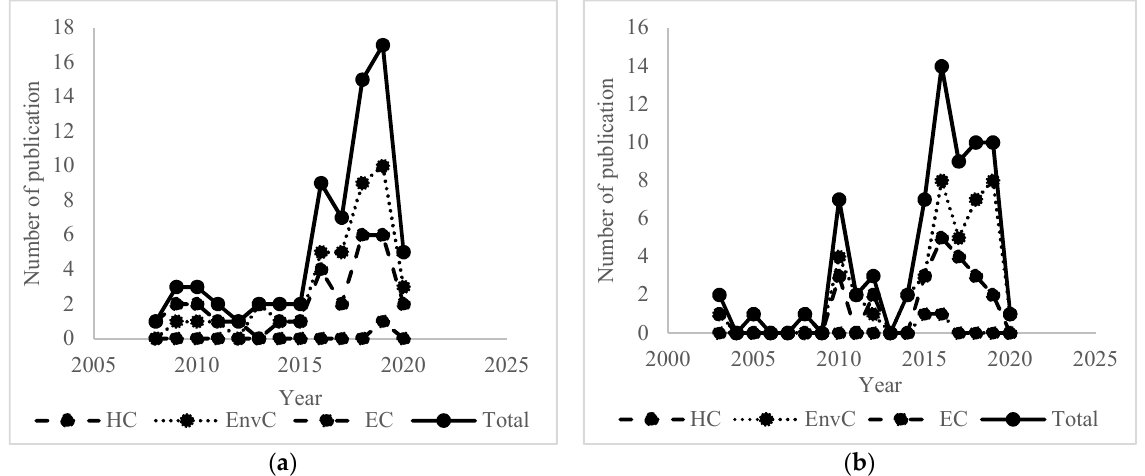
Figure 2. Distribution of 54 publications included in the meta-analysis ( a ) and 50 articles not included in the meta-analysis ( b ).